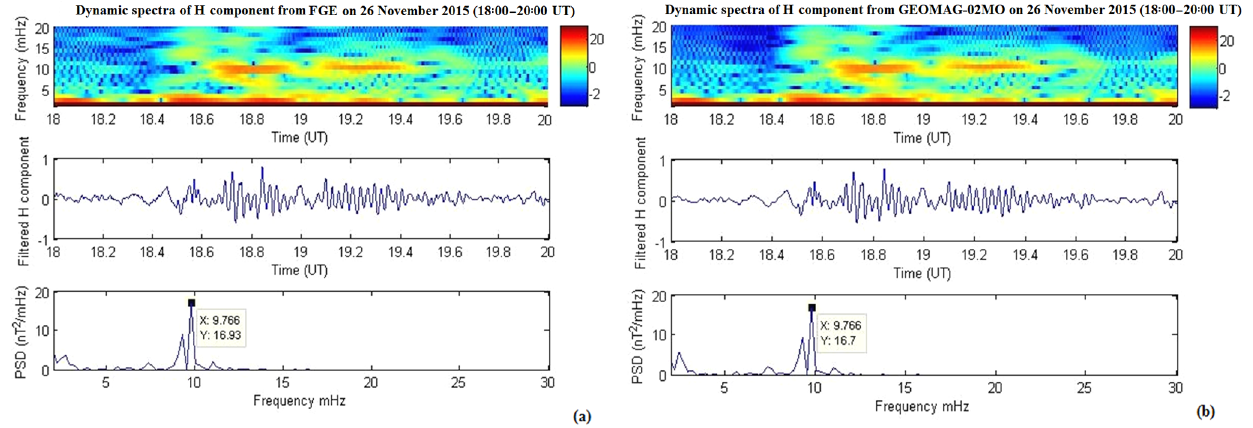
Figure 7. (a) Spectral decomposition of quiet day nighttime data from FGE on 26 November 2015. (b) Spectral decomposition of quiet day nighttime data from GEOMAG-02MO on 26 November 2015. PSD stands for power spectral